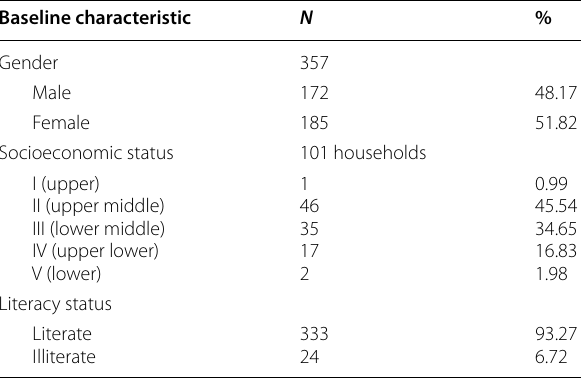
Table 1 Sociodemographic characteristics of participants Baseline